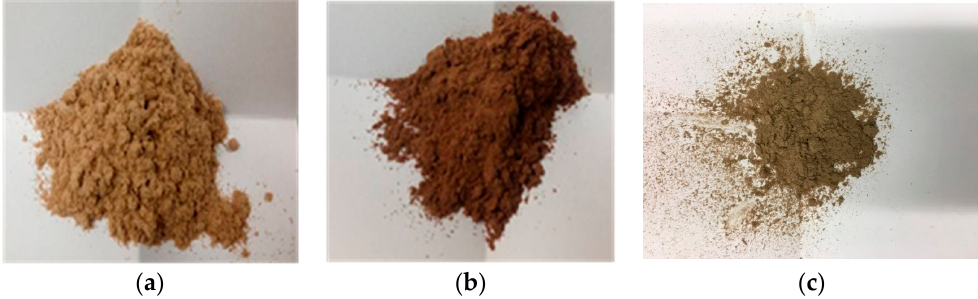
Figure 2. ( a ) Exhausted chestnut wood; ( b ) exhausted quebracho wood; ( c ) chestnut wood fiber.